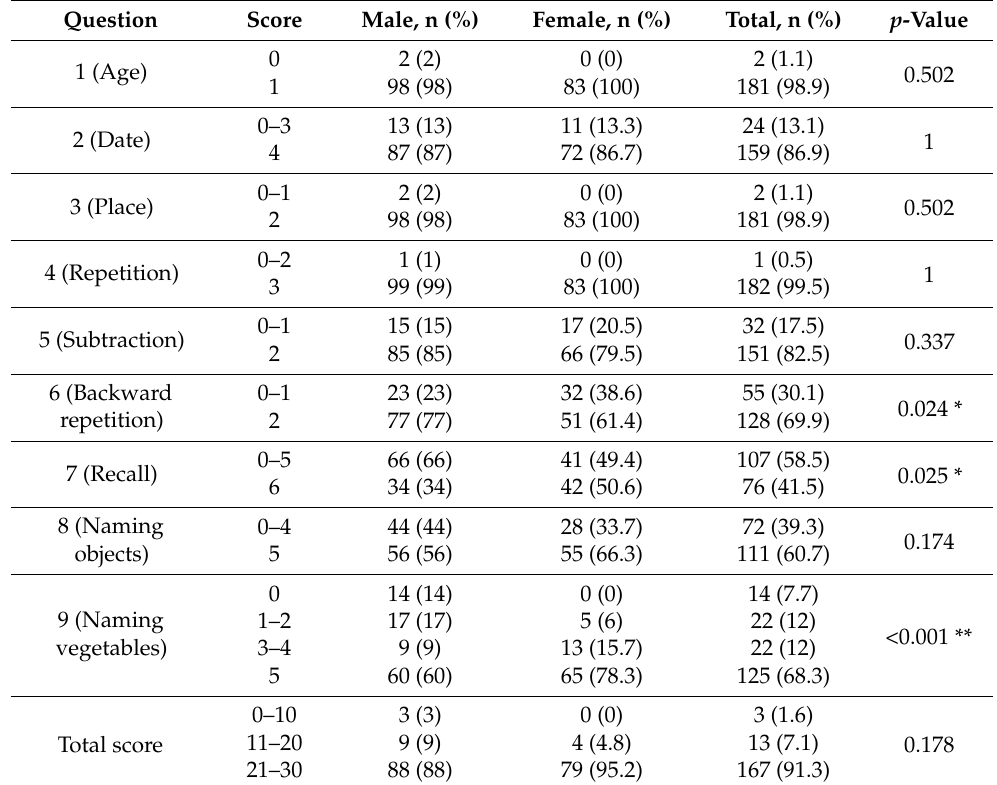
Table 3. Sex di ff erences for total score and individual item score on the HDS-R.